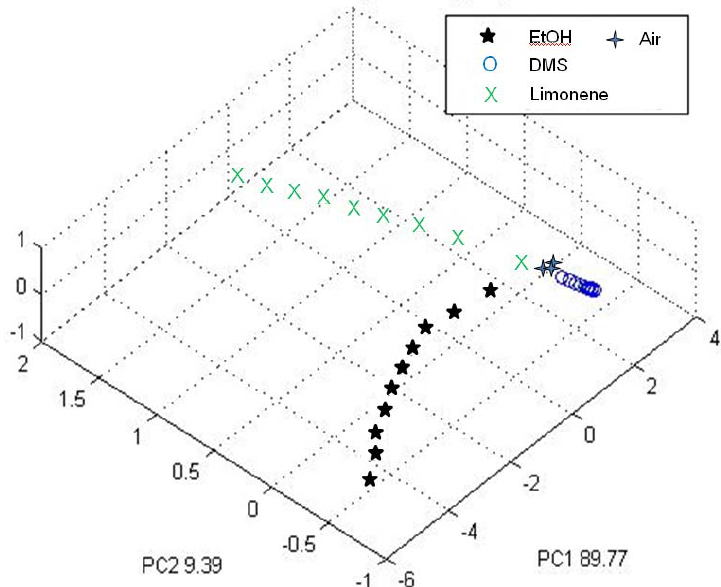
Figure 5. PCA of the laboratory tests measures performed with EOS